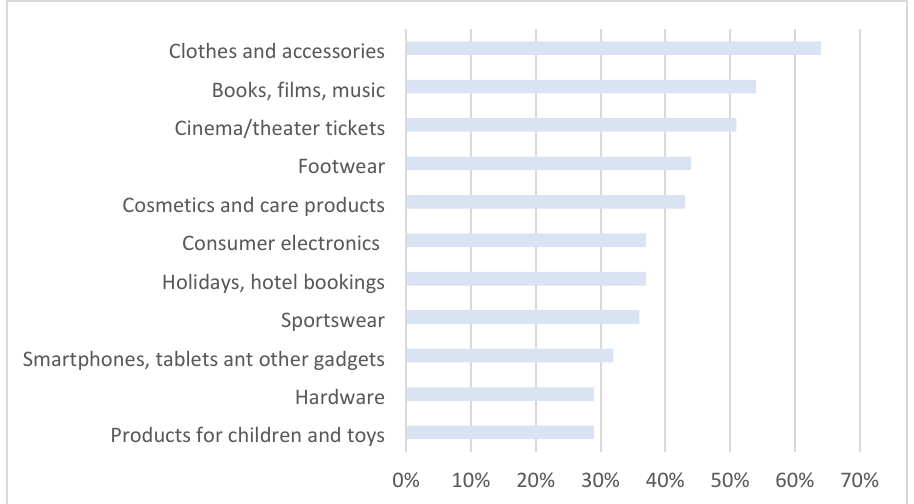
Figure 9. The most popular products e-shoppers bought online, in 2019 (source, own study based on information society in Poland). Results of statistical research in 2015–2019. GUS/Chief Statistical Office, Warsaw, Szczecin, Poland, 2019.